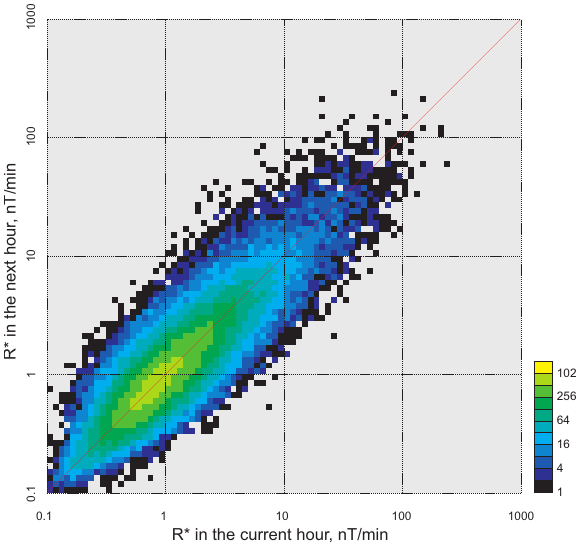
Fig. 8. R ∗ for next hour vs R ∗ for current hour computed from minute values at PAF: 2-D histogram.